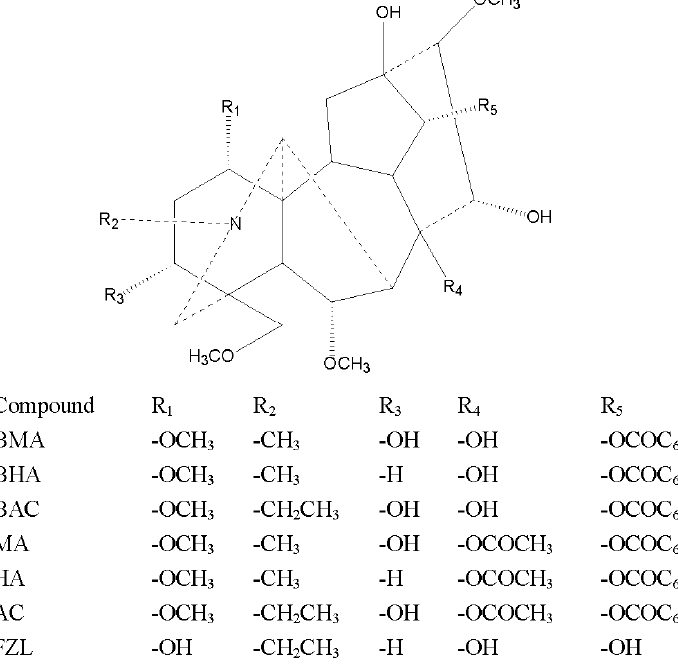
Figure 4. Chemical structures of alkaloids.